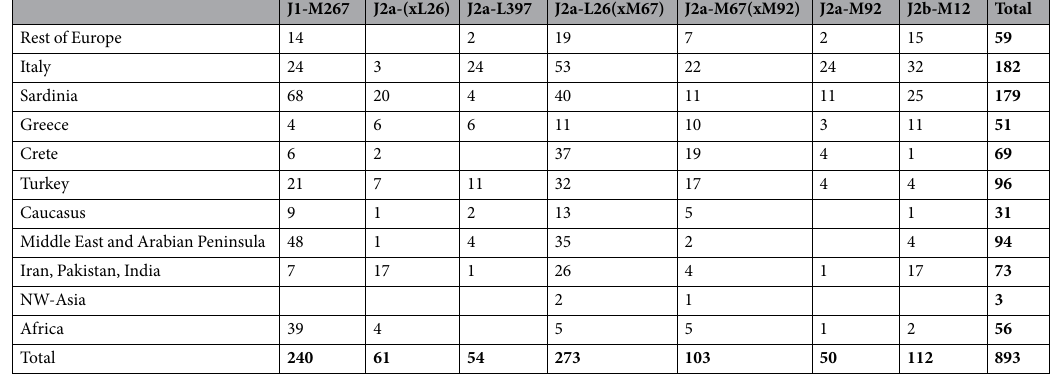
Table 1. Numerosity of the seven Hg J sub-haplogroups considered in this work, partitioned by sampling